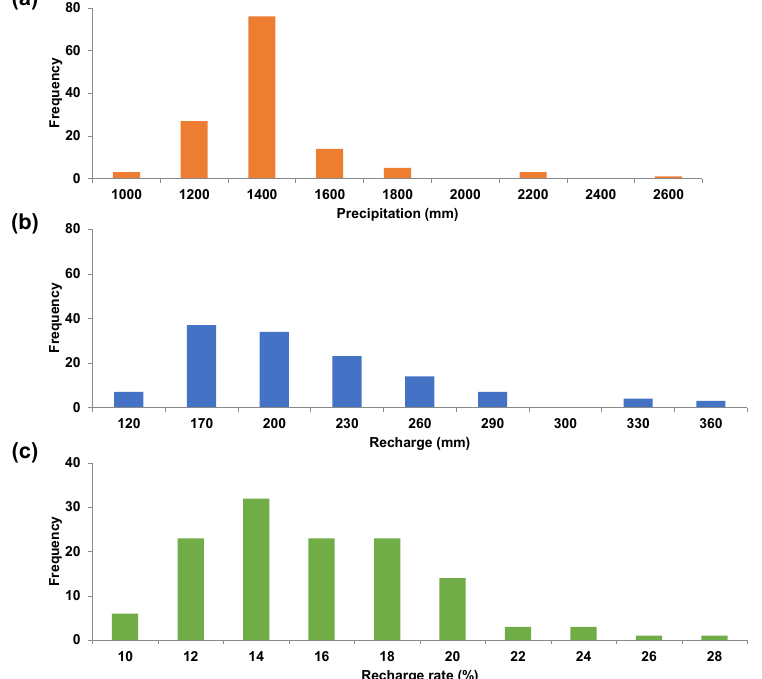
Figure 4. Histogram of the ( a ) precipitation, ( b ) recharge, and ( c ) recharge rate estimated surveyed in Korea, conducted from 1997 to 2020.